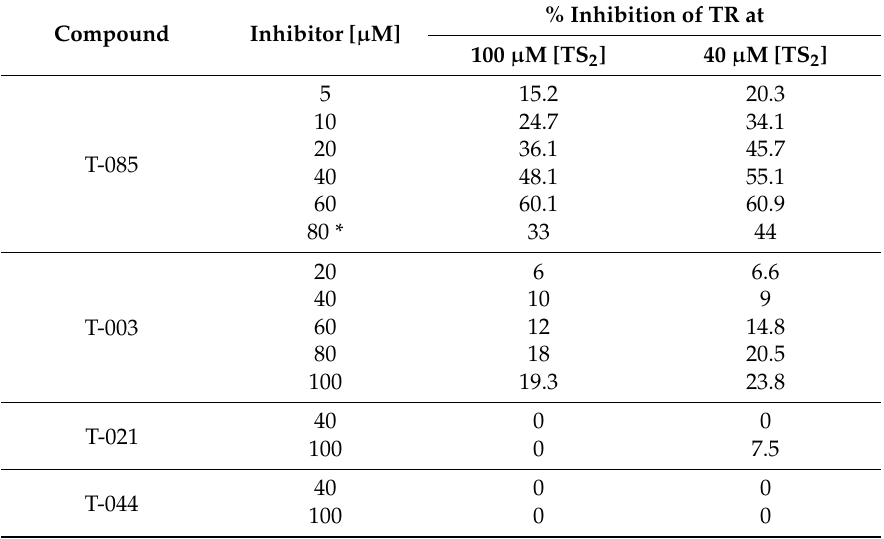
Table 4. Inhibition of T. cruzi TR by quinoxaline-7-carboxylate 1,4-di- N -oxide derivatives.